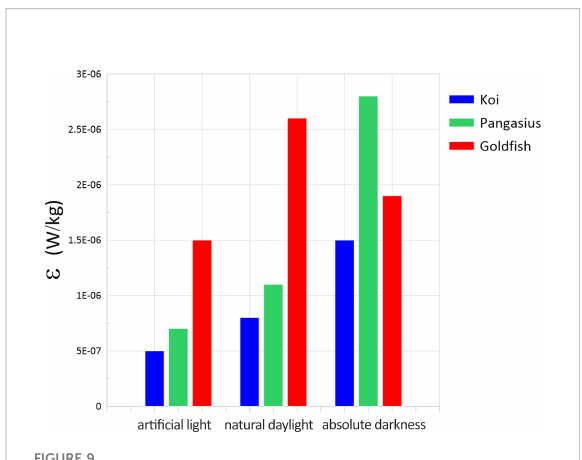
FIGURE 9 Dissipation rates of the fl ow generated by the schools of koi, pangasius, and gold fi sh as a function of the light level.